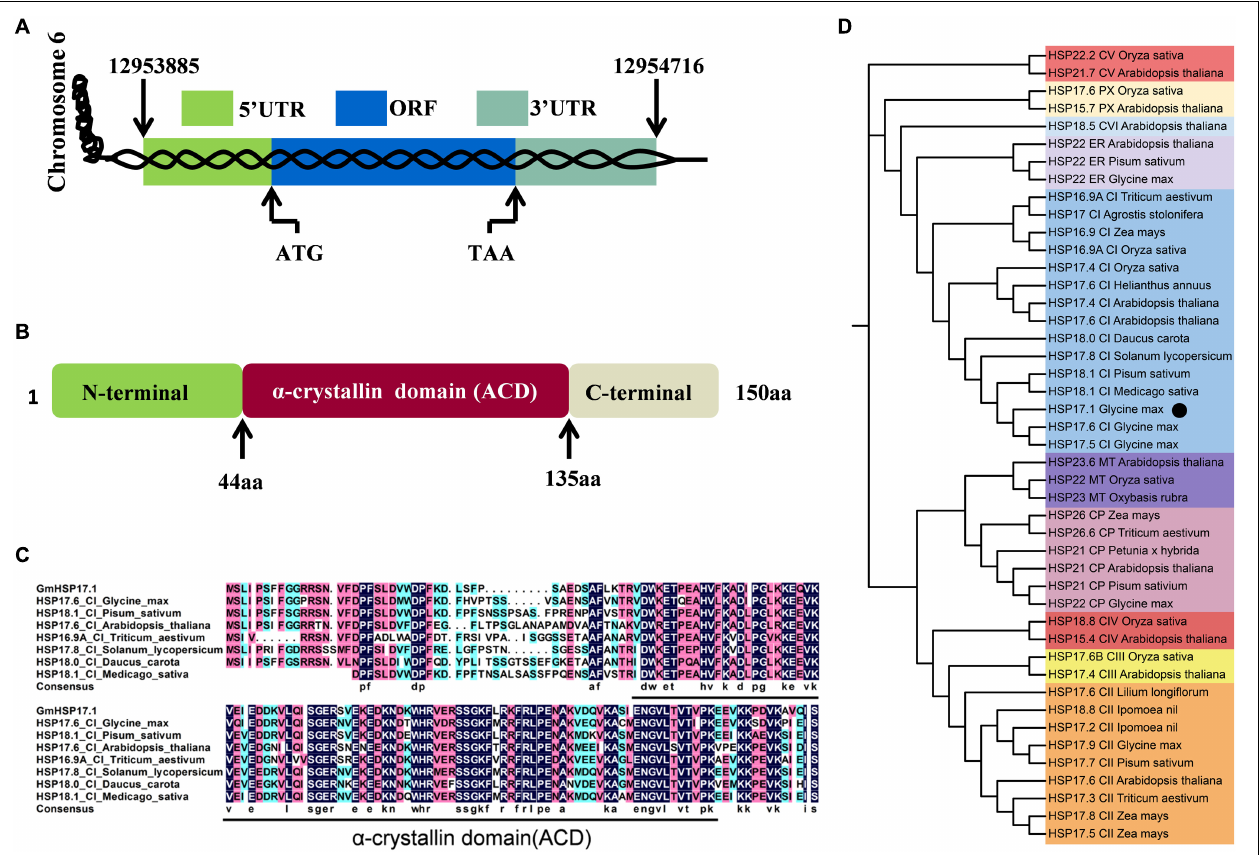
FIGURE 2 | Bioinformatics analysis of GmHSP17.1. (A) A genome sequence analysis of GmHSP17.1 . (B) The domain structure of GmHSP17.1 protein. α -crystallin domain (ACD) (44–135 aa), N-(1–43 aa), and C-(136–150 aa) terminal sequences are indicated. (C) The alignment of the amino acid sequences of GmHSP17.1 and other CI subfamily members in Glycine max , Pisum sativum , Arabidopsis thaliana, Triticum aestivum, Solanum lycopersicum, Daucus carota, and Medicago sativa . The alignment was performed using DNAMAN. The black line indicated the ACD domain. (D) Phylogenetic tree analysis of GmHSP17.1. Phylogenetic tree was conducted by the MEGA7 software. Accession numbers of the sHSPs were: Glycine max (HSP17.9, NP_001346002; HSP17.5, NP_001362775.1; HSP17.6, NP_001347279.1; HSP22, NP_001347237.1; HSP22, NP_001236586.2), Agrostis stolonifera (HSP17, ALR99802.1), Arabidopsis thaliana (HSP17.6, NP_175759.1; HSP17.4, NP_190209.1; HSP17.6, NP_196763.1; HSP17.4, NP_001323264.1; HSP15.4, NP_193918.1; HSP21.7, NP_568810.1; HSP18.5, NP_179521.1; HSP15.7, NP_198583.1; HSP21, NP_194497.1; HSP23.6, NP_194250.1; HSP22, NP_192763.1), Daucus carota (HSP18.0, P27397.1), Helianthus annuus (HSP17.6, XP_021973842.1), Solanum lycopersicum (HSP17.8, NP_001266045.1), Medicago sativa (HSP18.1, P27879.1), Oryza sativa (HSP16.9A, XP_015625199.1; HSP17.4, XP_015631117.1; HSP18.8, XP_015645510.1; HSP22.2, XP_015638251.1; HSP17.6, XP_015641984.1; HSP22,